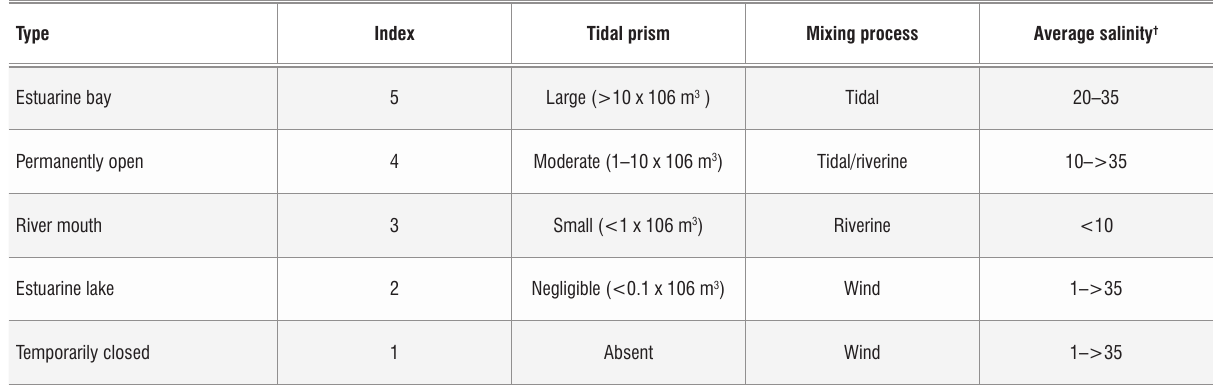
Whitfield’s 38 physical classification of